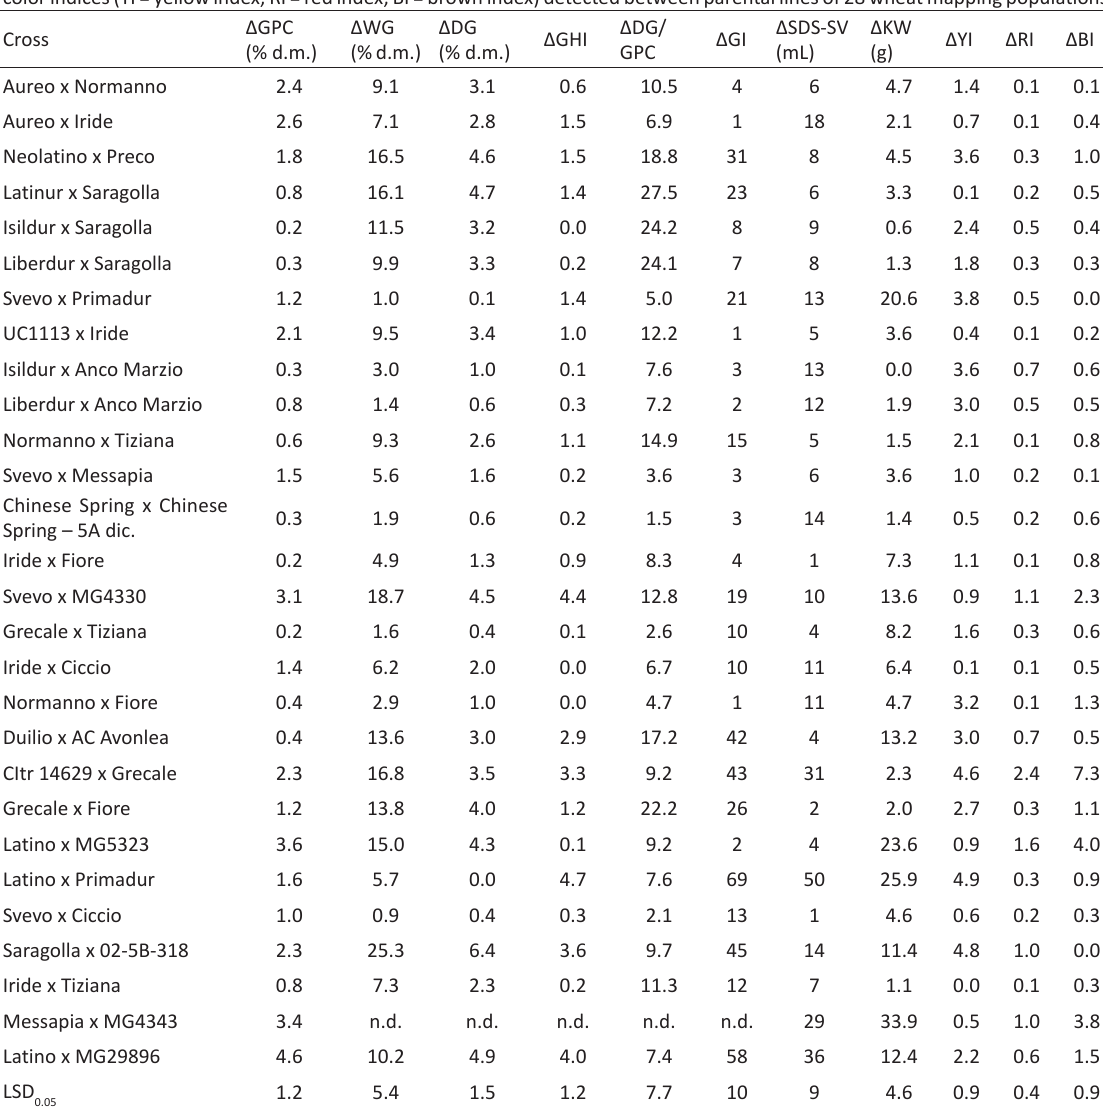
Table 7. Differences in grain protein content (GPC), wet gluten (WG), dry gluten (DG), gluten hydration index (GHI), dry gluten/protein ratio (DG/GPC), gluten index (GI), sodium dodecyl sulphate sedimentation volume (SDS-SV), thousand-kernel weight (KW), and color indices (YI = yellow index; RI = red index; BI = brown index) detected between parental lines of 28 wheat mapping populations ΔDG/ ΔGPC ΔWG ΔDG ΔGHI Cross GPC (% d.m.) (% d.m.) (% d.m.)